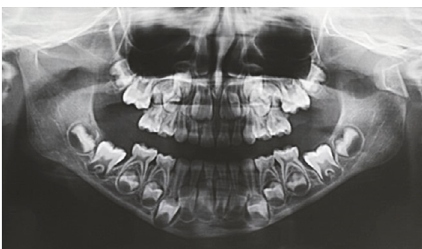
Figure 2: The large fracture area between the ramus and condylar